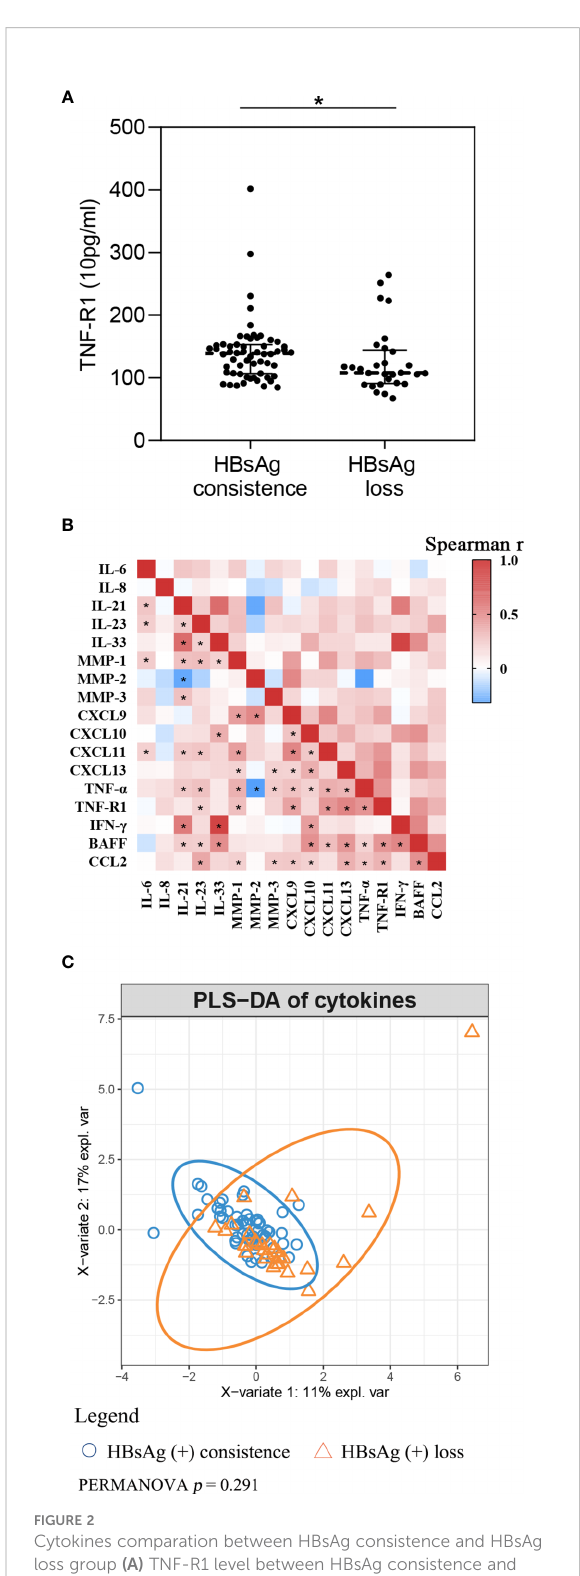
FIGURE 2 Cytokines comparation between HBsAg consistence and HBsAg loss group (A) TNF-R1 level between HBsAg consistence and HBsAg loss group; (B) Spearman correlation among cytokines. Red, means positive correlation; blue, means negative correlation; * p < 0.05 in Spearman correlation test. (C) Partial least squares discriminant analysis of